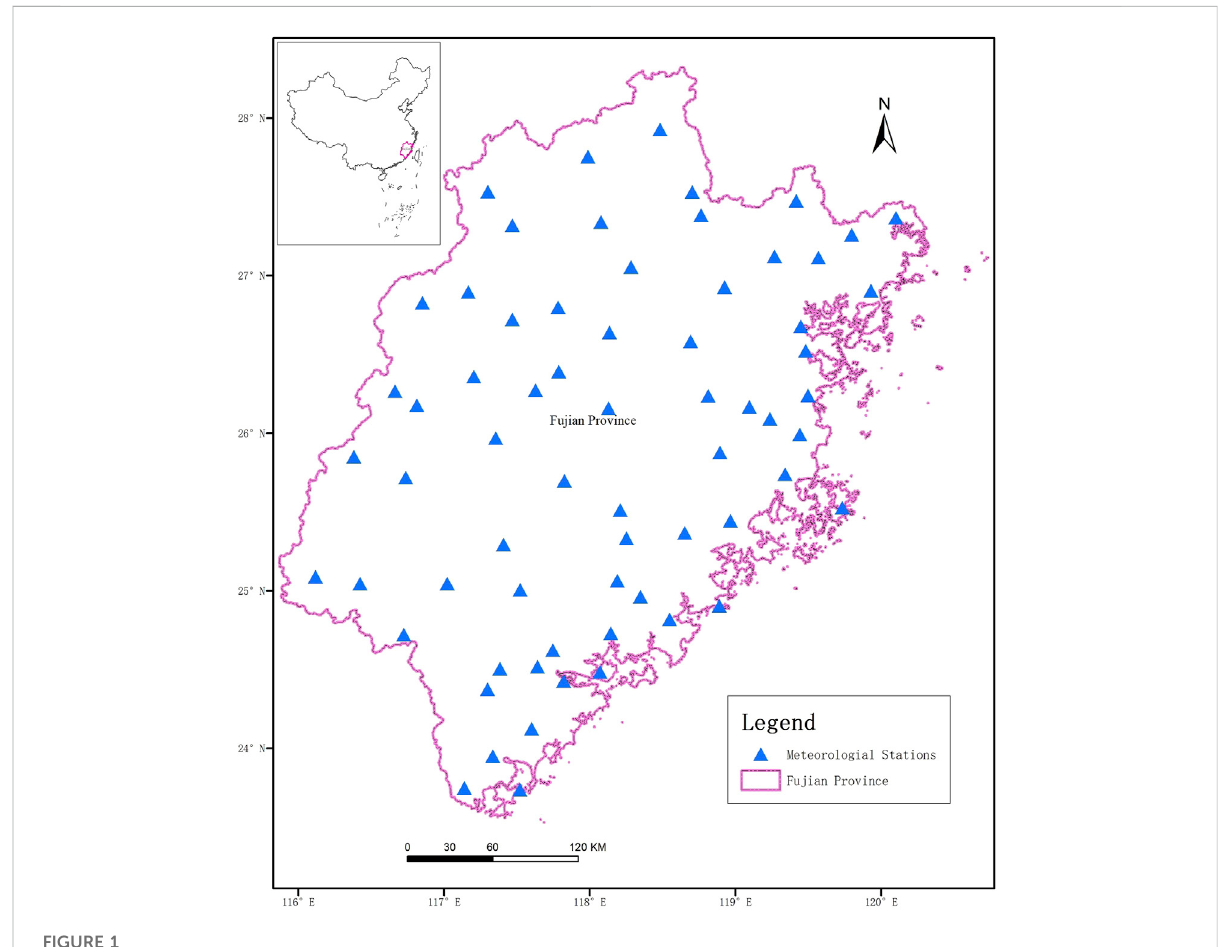
FIGURE 1 Location of study area and meteorological